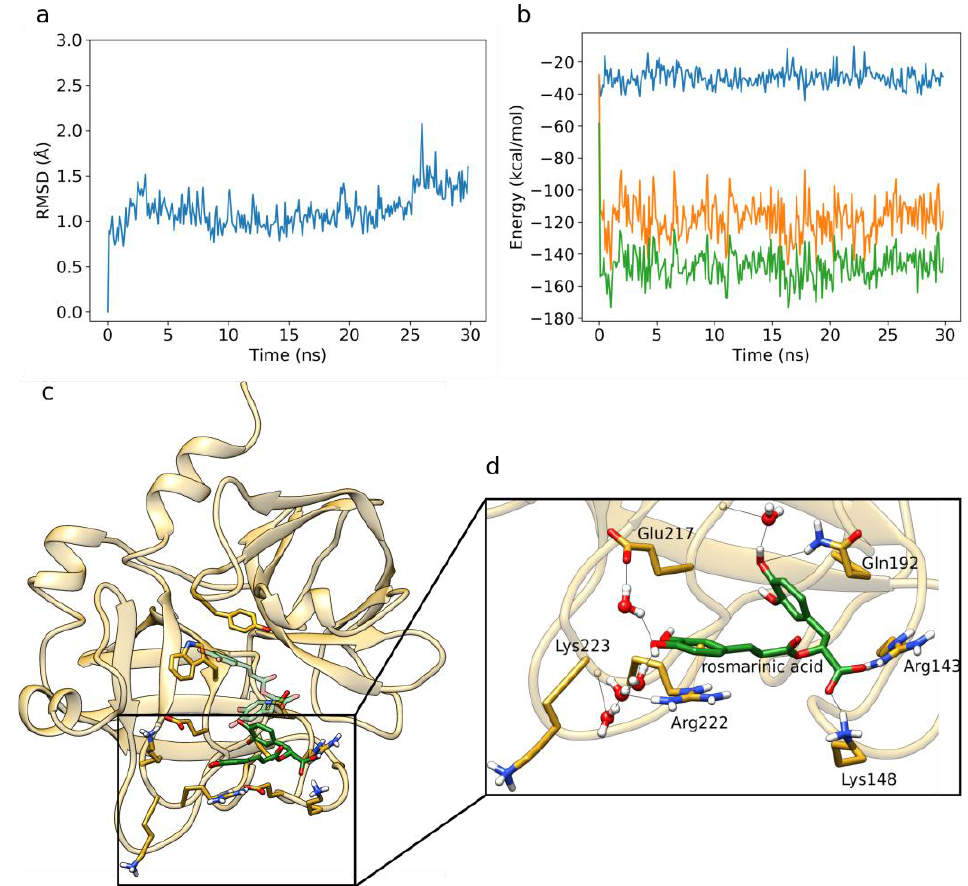
Figure 7. MD simulation of rosmarinic acid bound to factor X. ( a ) RMSD of the protein backbone of the analyzed MD simulation. ( b ) Interaction energy analysis describing the binding between rosmarinic acid and factor X as observed in the MD simulation. ( c ) Rosmarinic acid (carbons depicted in green sticks) occupies a different binding pose compared to the one obtained by molecular docking (carbons shown in transparent green sticks). ( d ) Rosmarinic acid binding within the factor X binding site during the MD simulations. Direct H-bonding interactions are shown with black lines, and the cation– π interaction is shown with an orange line. We display interactions present with an occupancy >50%.